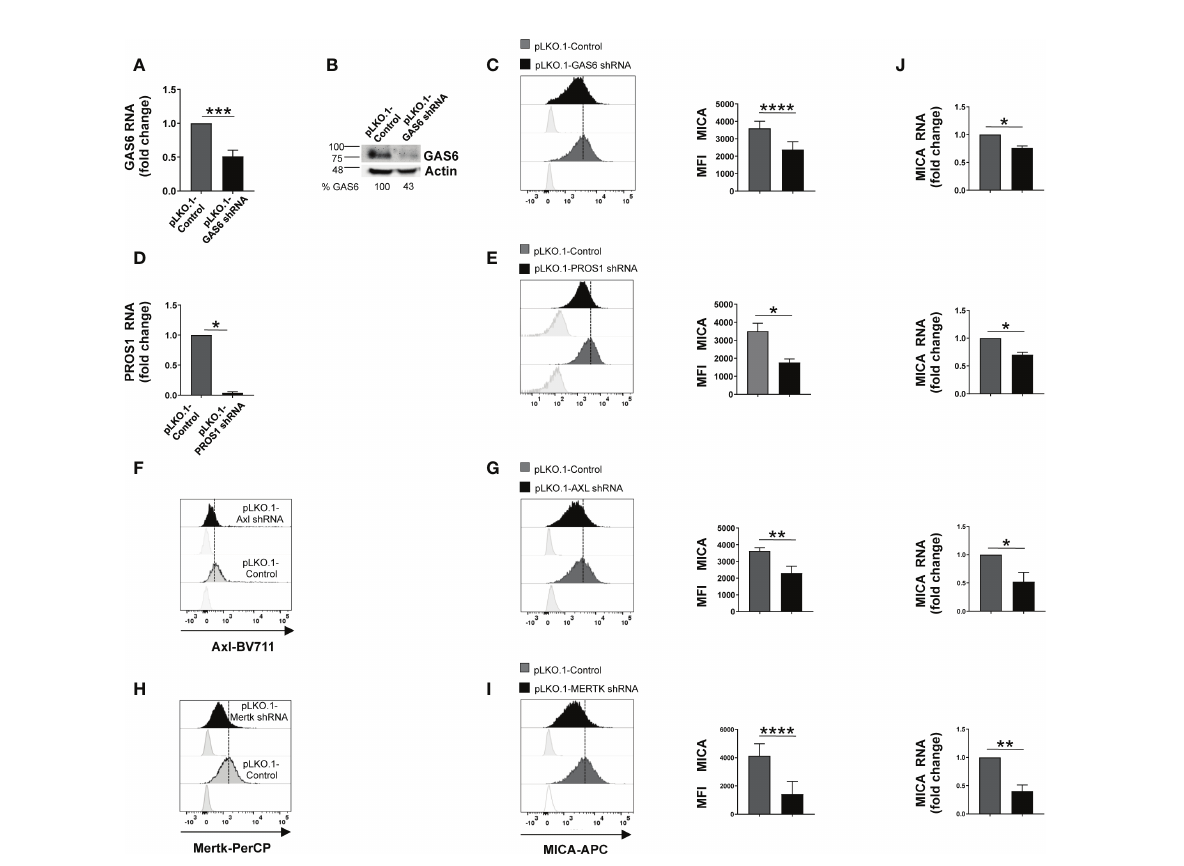
FIGURE 1 Silencing of GAS6, PROS1 or TAM receptors reduces MICA expression in SKO-007(J3) cells. Total mRNA and protein extracts obtained from SKO-007(J3) pLKO.1-GAS6 shRNA or pLKO.1-PROS1 shRNA and pLKO.1-Control were analyzed for GAS6 or PROS1 expression by real-time PCR (A – D) and Western Blot (B) . AXL and MERTK receptor expression was analyzed by FACS on SKO-007(J3) pLKO.1-Control, pLKO.1-AXL shRNA (F) or pLKO.1-MERTK shRNA (H) . MICA expression was analyzed by fl ow cytometry and real-time PCR in SKO-007(J3) pLKO.1-GAS6 shRNA (n=6) (C) , pLKO.1-PROS1 shRNA (n=3) (E) , pLKO.1-AXL shRNA (n=6) (G) , pLKO.1-MERTK shRNA (n=6) (I) or pLKO.1-Control. Histograms represent the MFI of speci fi c mAb subtracted of MFI of isotype control. Data are shown as mean ± SD (****p < 0.001; ***p < 0.005; **p < 0.01; *p < 0.05 Mann-Whitney Test). For real-Time PCR analysis (J) , data, expressed as fold change units, were normalized with GAPDH and referred to pLKO.1-Control, considered as calibrator. Data are shown as mean ± SD (**p < 0.01; *p < 0.05; Mann-Whitney